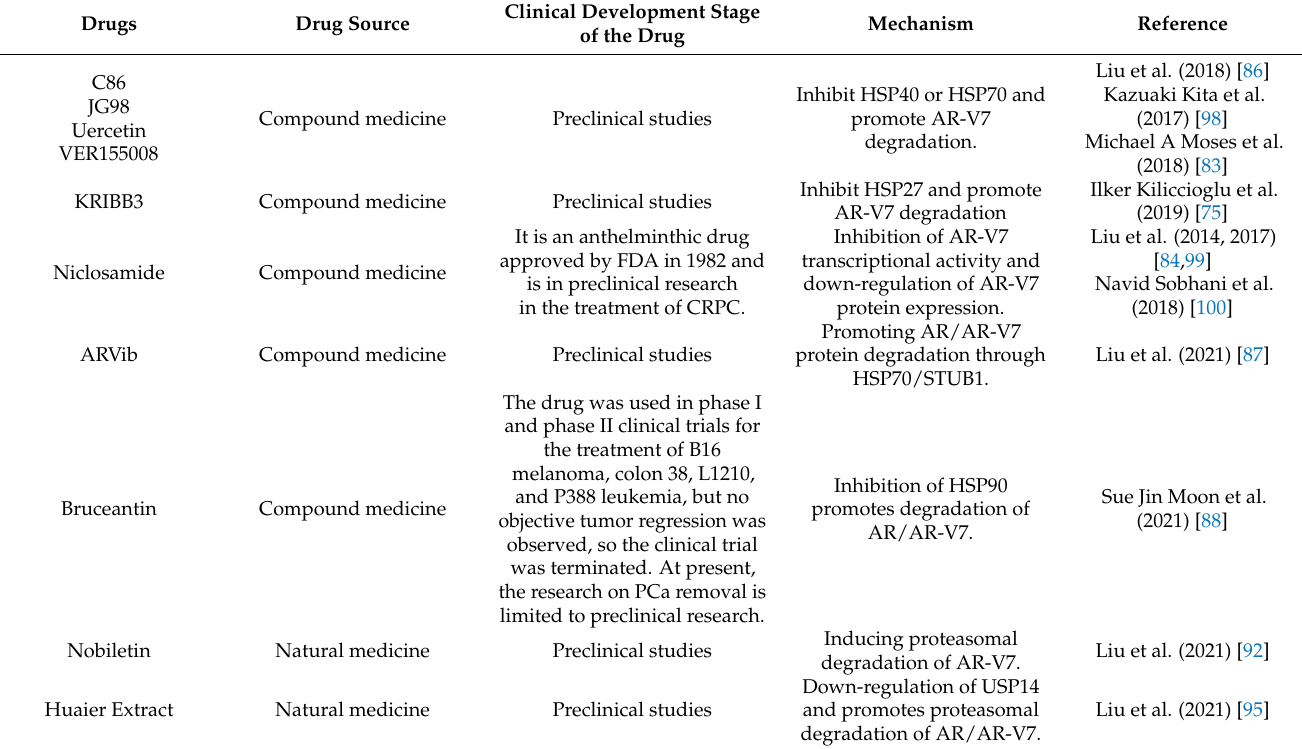
Table 1. Drugs and correlated mechanisms in